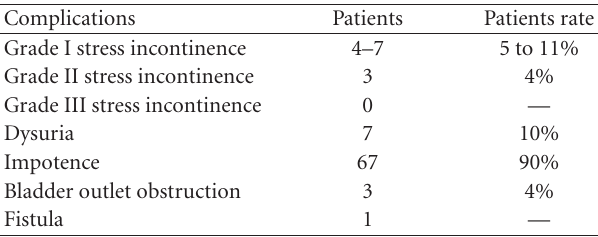
Table 1: Complications and complication rate after HIFU treat- ment.